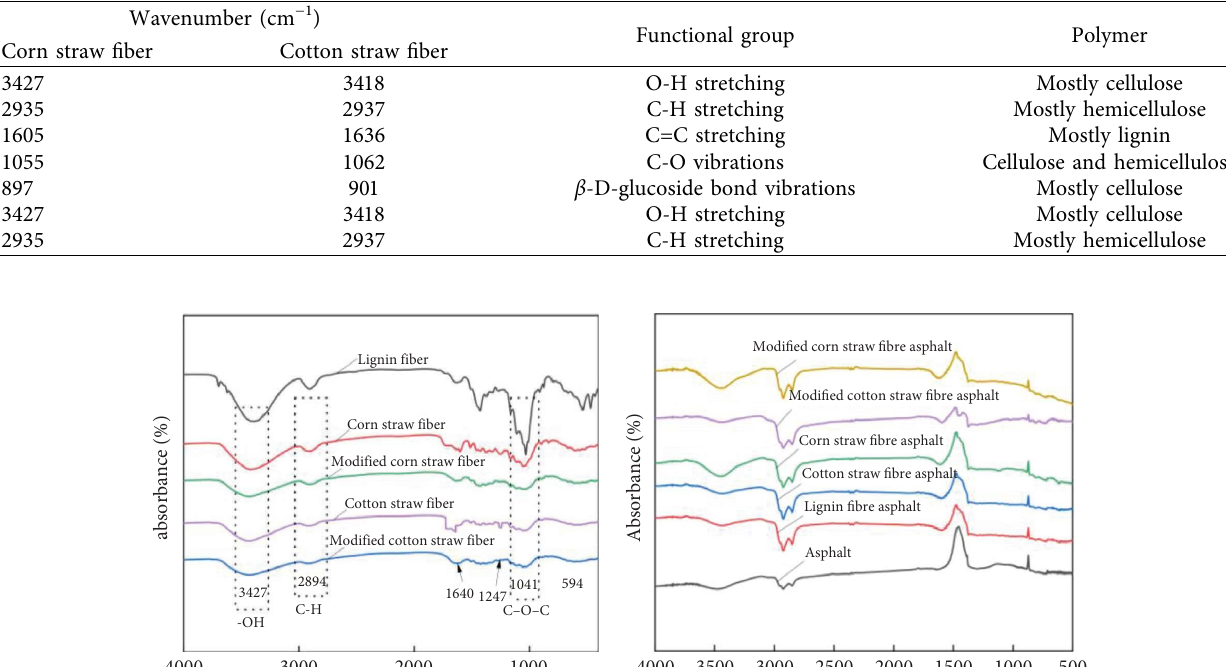
Table 6: Common absorption peaks of two types of straw fbers.